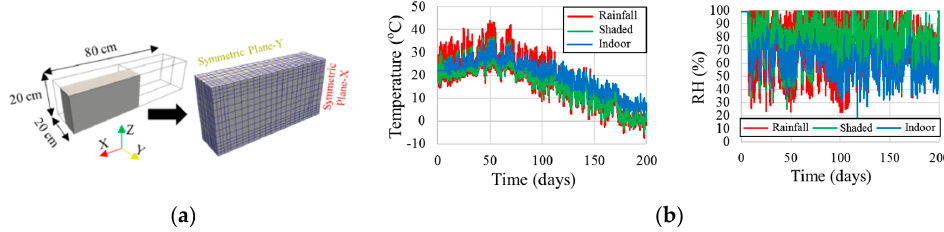
Figure 3. ( a ) Finite-element (FE) model of one fourth of the specimen; ( b ) environmental condition. Table 1. Mix proportion of 200 × 200 × 800 mm 3 prismatic specimens and curing condition.